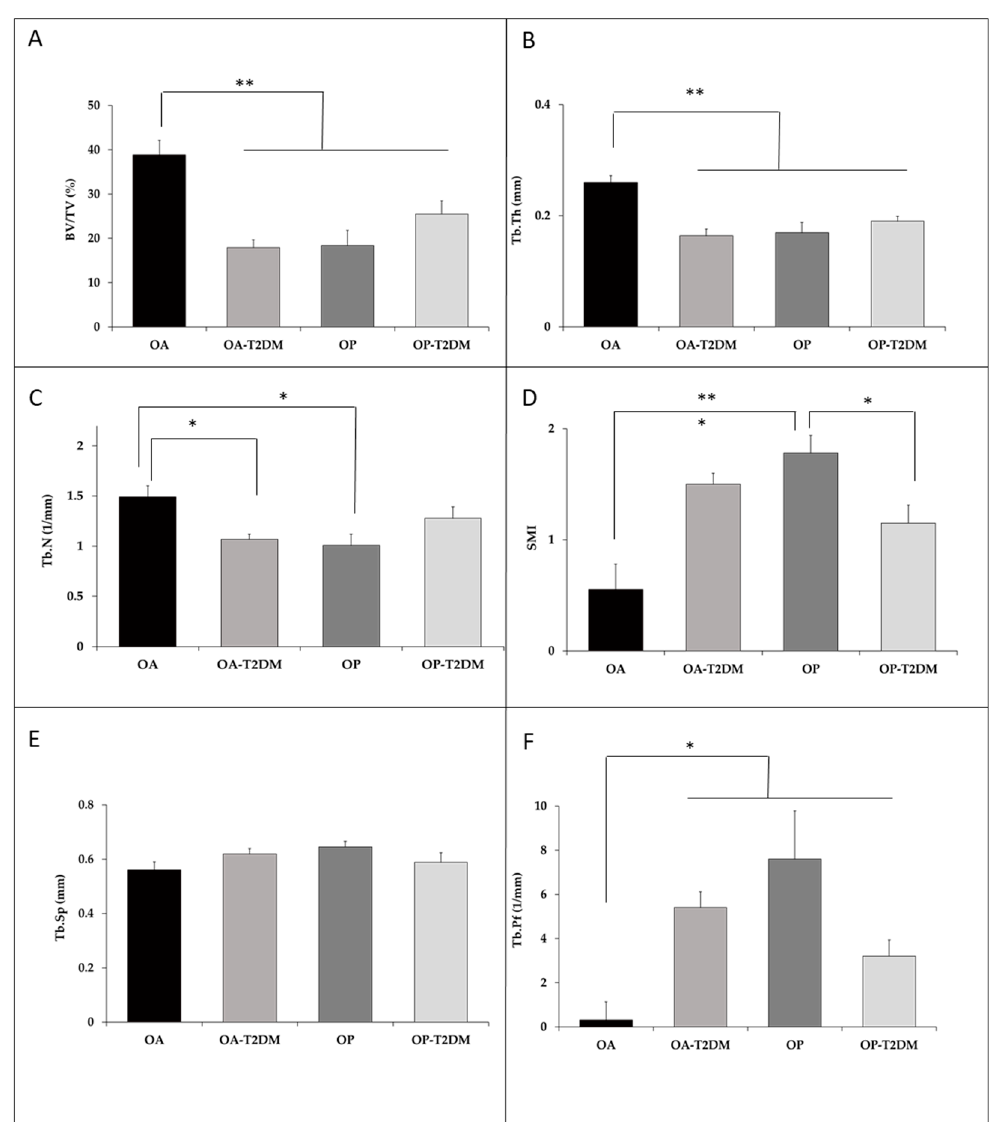
Figure 3. Comparisons of structural parameters between patients with OA and OP with or without T2DM. ( A ) BV/TV, bone volume fraction; ( B ) Tb.Th, trabecular thickness; ( C ) Tb.N, trabecular number; ( D ) SMI, structural model index; ( E ) Tb.Sp, trabecular separation; ( F ) Tb.Pf, trabecular bone pattern factor; Values are expressed as the means ± SEM. * p < 0.05, ** p < 0.01, statistically significant.